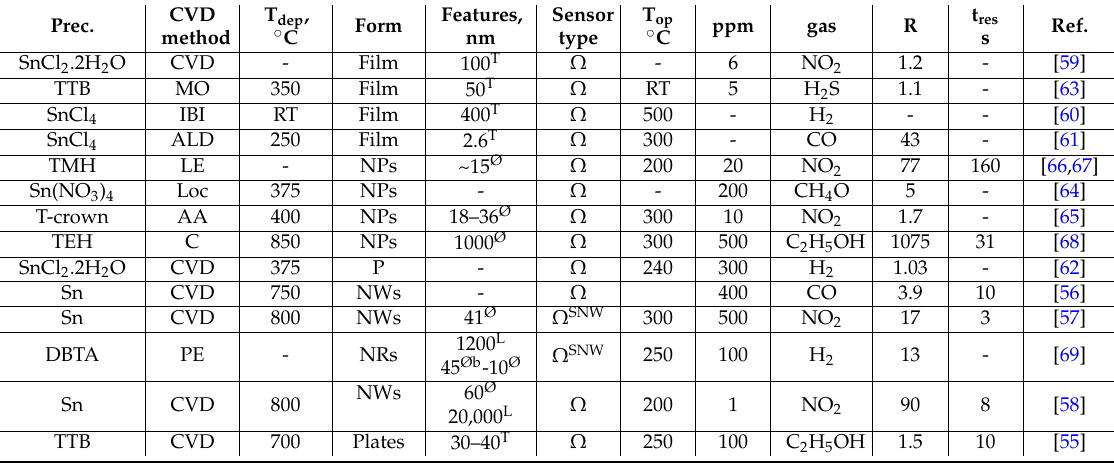
Table 3. Summary of the features and sensing properties reported for chemical vapour deposited tin